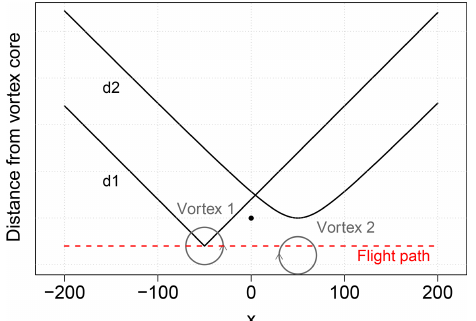
Figure 10. Analytical solution of a UAS passing the vortex at a path crossing the centre (solid black line), passing at r = 0 . 5 r c (red line) and at a distance double the core radius (dashed black line). The peak-to-peak distance is 2 L (see Fig. 9), illustrated above for the solid black line.